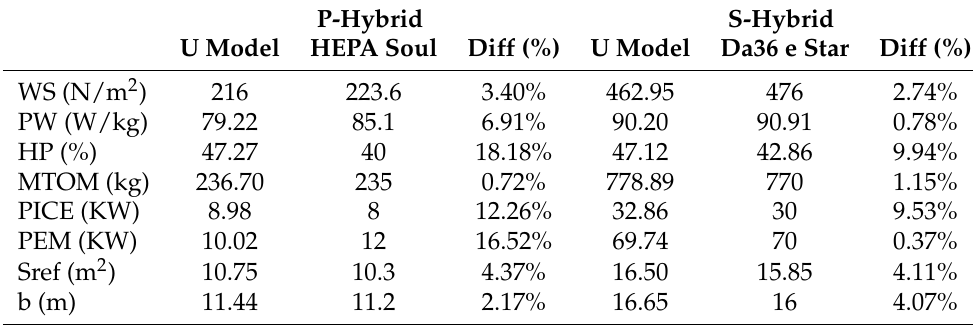
Table 6. Real aircraft comparison.